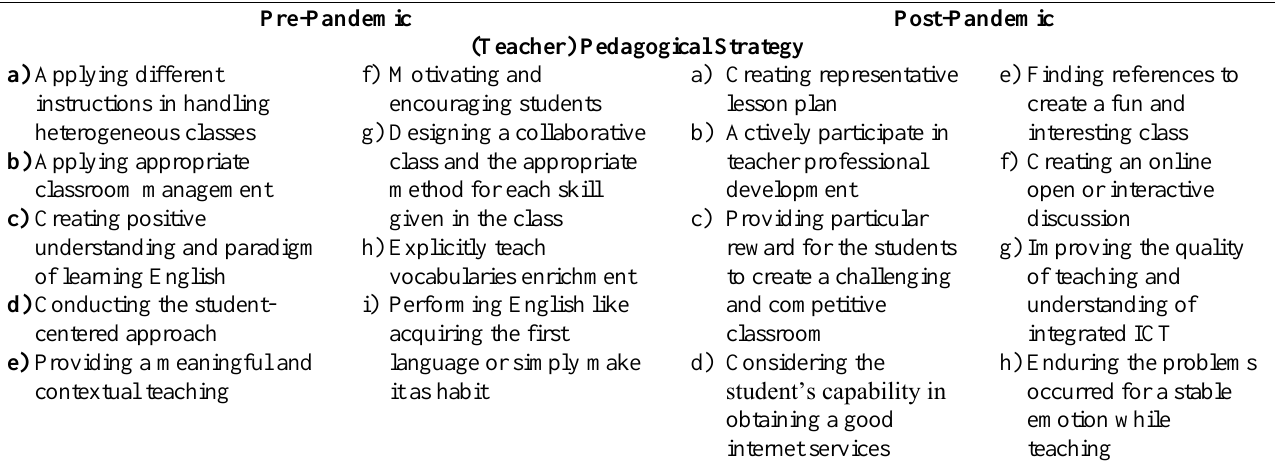
TABLE 11 | (Teacher) Pedagogical Strategy